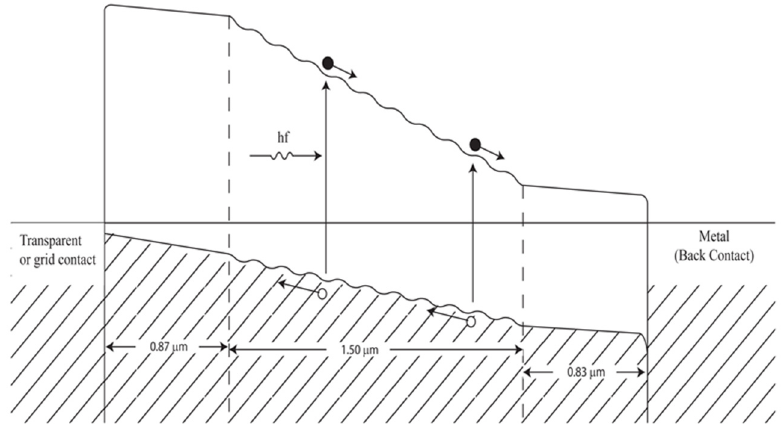
Figure 9. The shape of the energy band diagram of the devices fabricated during first growth due to high doping concentrations at both ends of the structure.